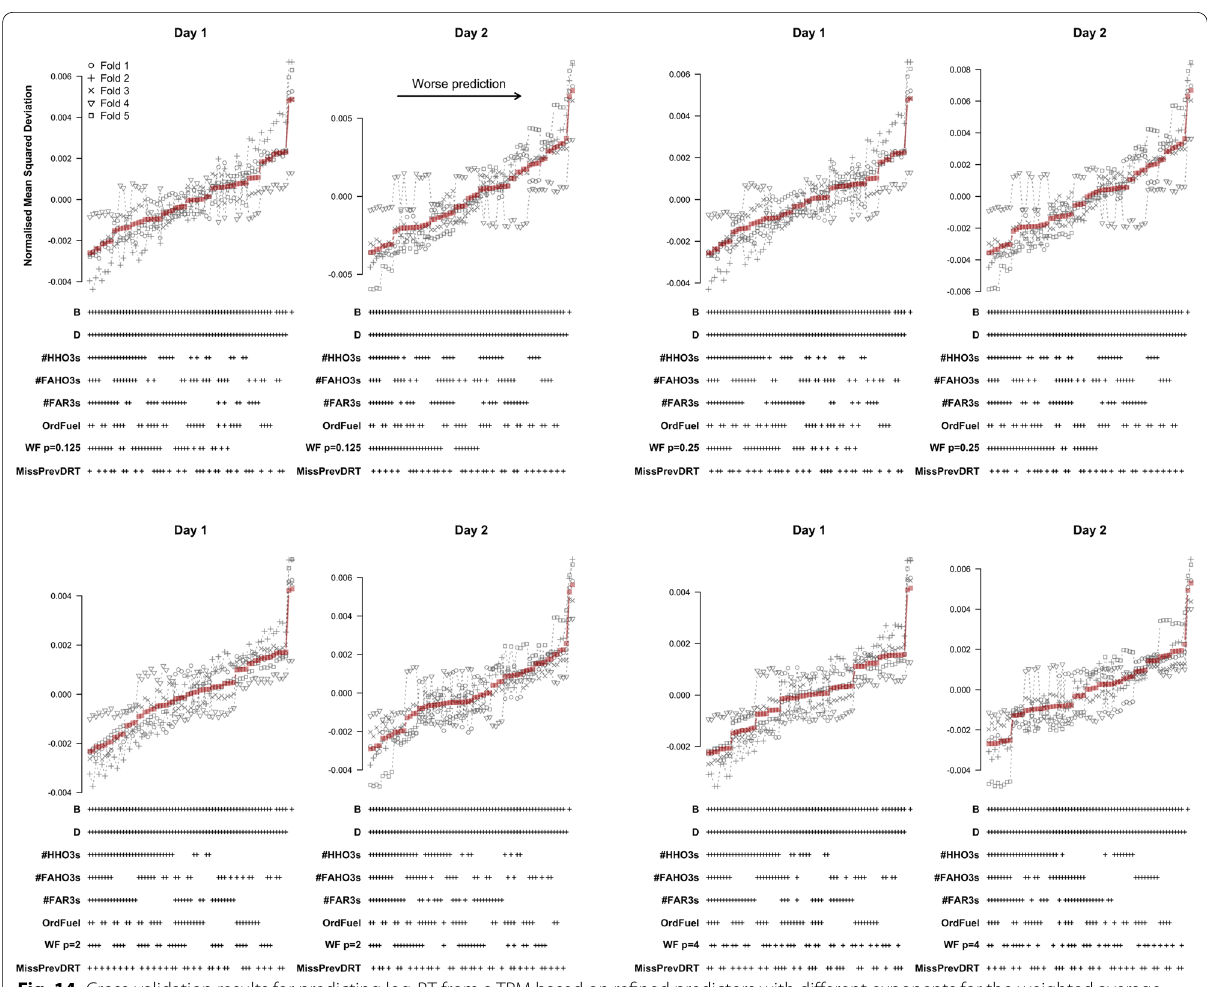
Fig. 14 Cross-validation results for predicting log-RT from a TPM based on refined predictors with different exponents for the weighted average fuel-load predictor. Note that in order to make comparison easy the results in the top right panel repeat those in Fig.